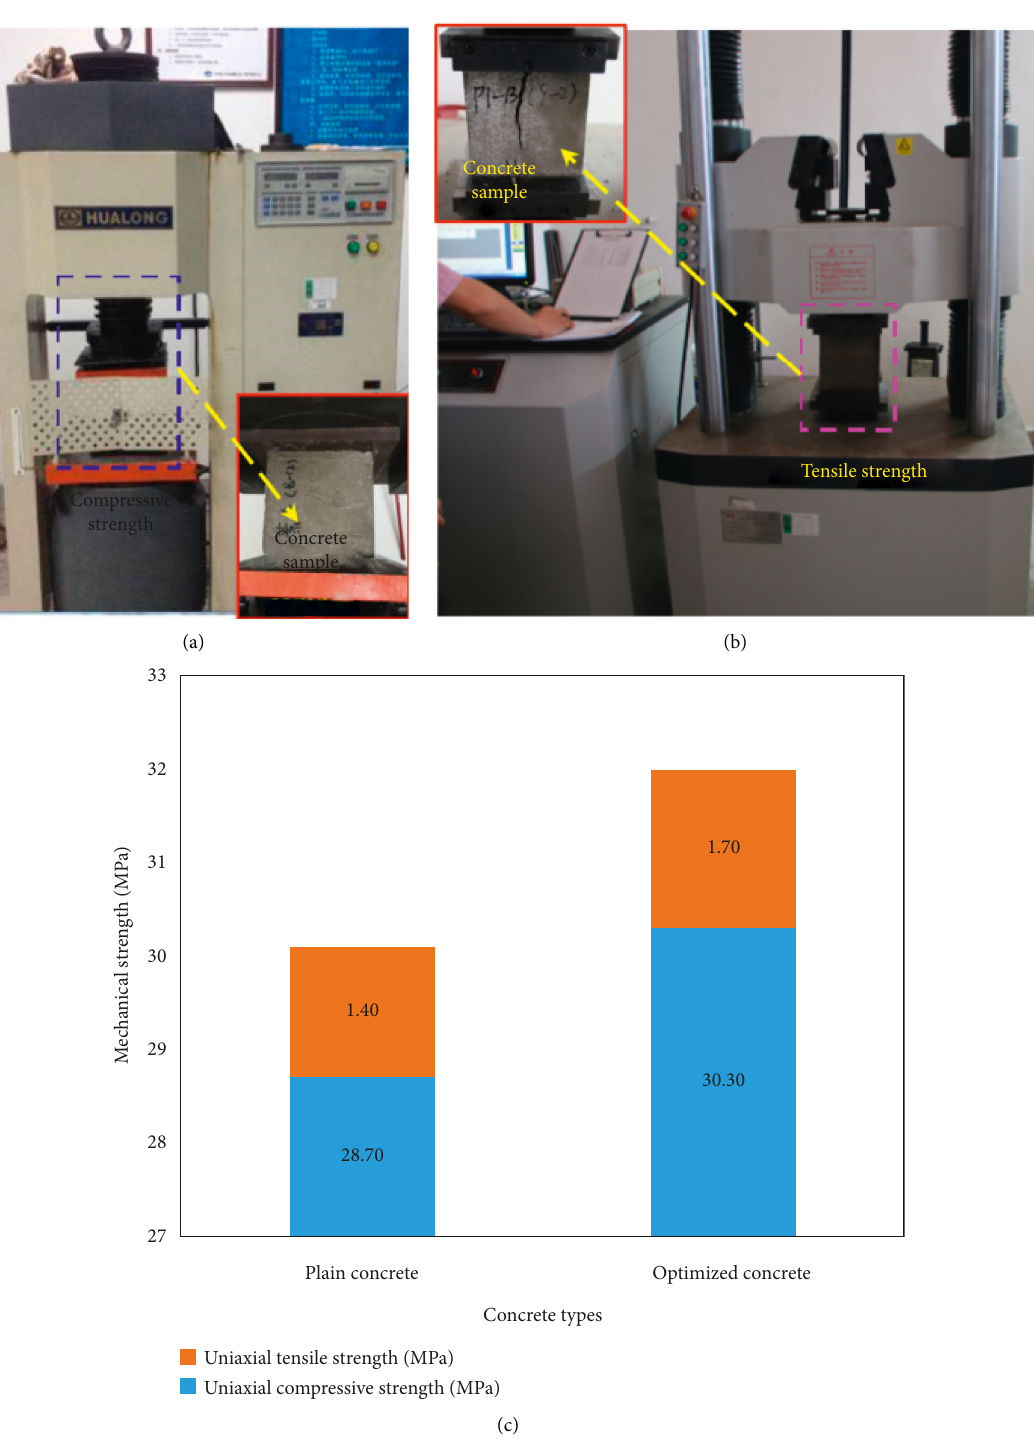
Figure 9: Mechanical strength test of plain concrete and optimized concrete samples: (a) electrohydraulic mechanical press, (b) elec- trohydraulic servo universal testing machine, and (c) mechanical strength test results (note: the optimized concrete represents 1.0% PA8 concrete